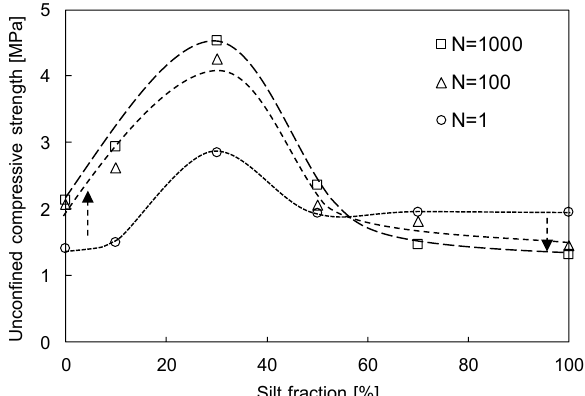
Figure 11. Variation of unconfined compressive strength versus SF of sand–silt mixtures subjected to N = 1, 100, and 1000.